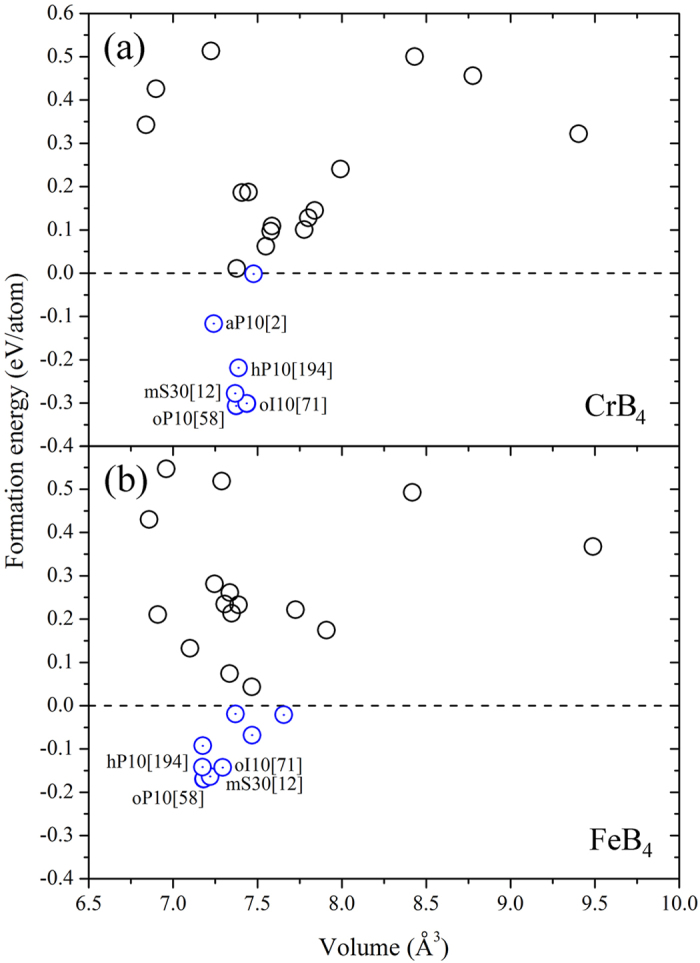
Formation energies of TmB4 after geometrical optimizations.Formation energy of (a) CrB4 and (b) FeB4 calculated by DFT to determine the possible ground state phases of 26 commonly observed Tm-B, Tm-Al, Tm-P, Tm-O, Tm-S ICSD structure types and the newly reported tetraborides. The most stable structure is confirmed by our evolutionary search method.